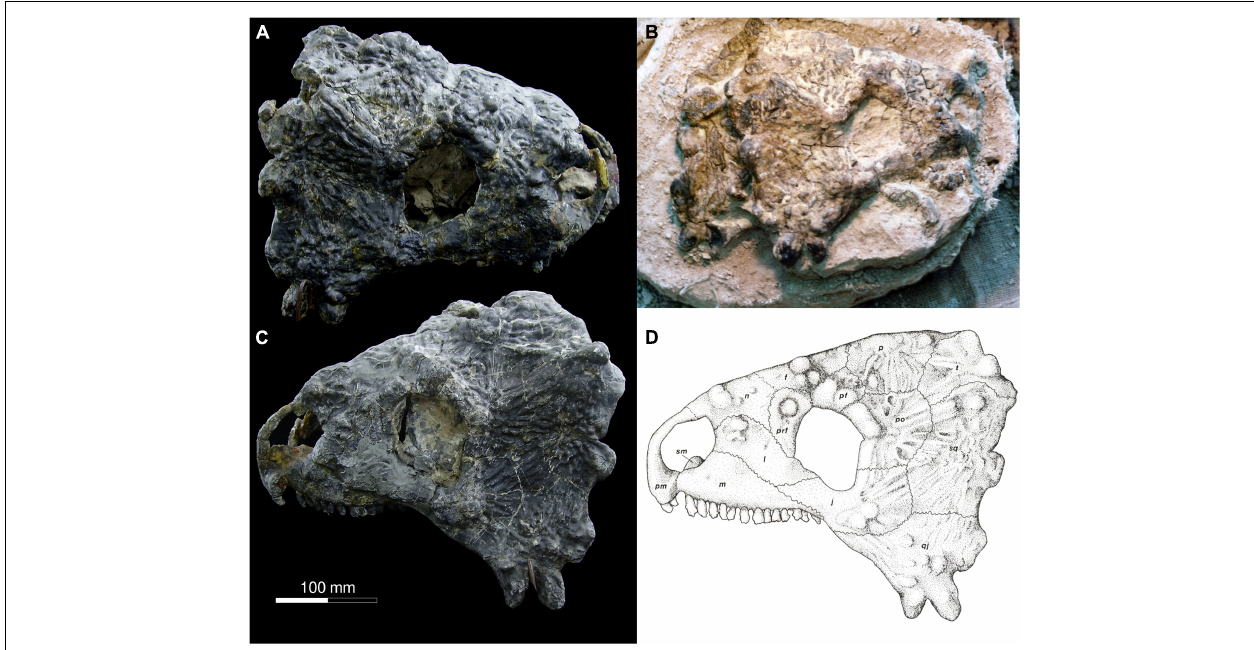
FIGURE 4 | Skull of Provelosaurus americanus , UFRGS-PV-0231-P (holotype). (A) Right lateral view; (B) field photograph showing right lateral view and partial medial view of left side of skull (photo from the UFRGS-PV collection), (C) left lateral view; (D) original drawing from Araújo (1985a). Scale bar for (A,C,D) .